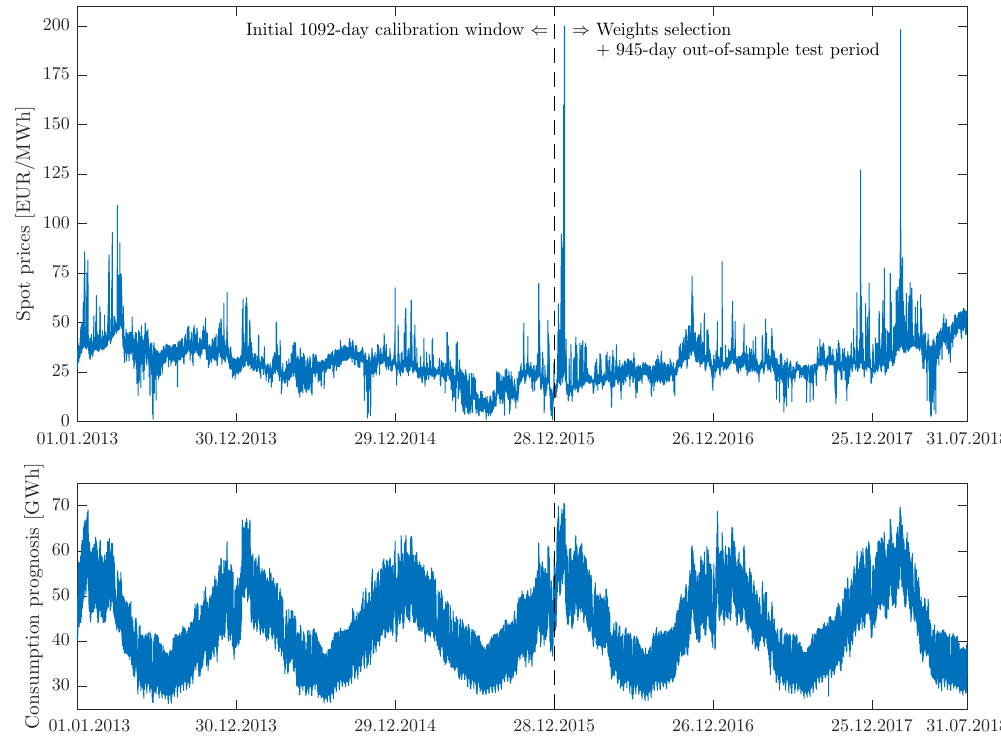
Figure 1. Nord Pool (NP) hourly system prices ( top ) and hourly consumption prognosis ( bottom ) from 1 January 2013 to 31 July 2018. The vertical dashed lines mark the end of the initial 1092-day calibration window (i.e., 1 January 2013–28 December 2015). Weights for the WAW approach (see Section 2.5) are selected based on price predictions for the following day (i.e., 29 December 2015 for the initial calibration windows) and the remaining observations constitute the 945-day out-of-sample test